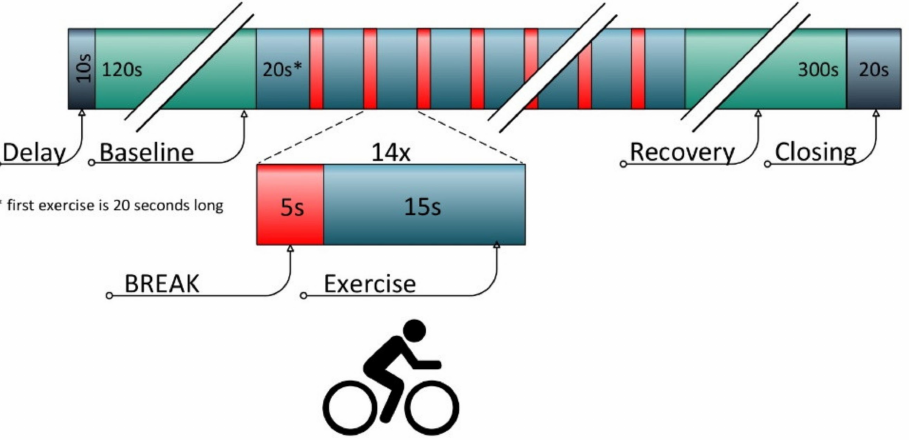
Figure 10. Timeline ergometry stress test —green-marked are baseline phase at the start and recovery phase at the end, red-marked are the breaks between the exercise